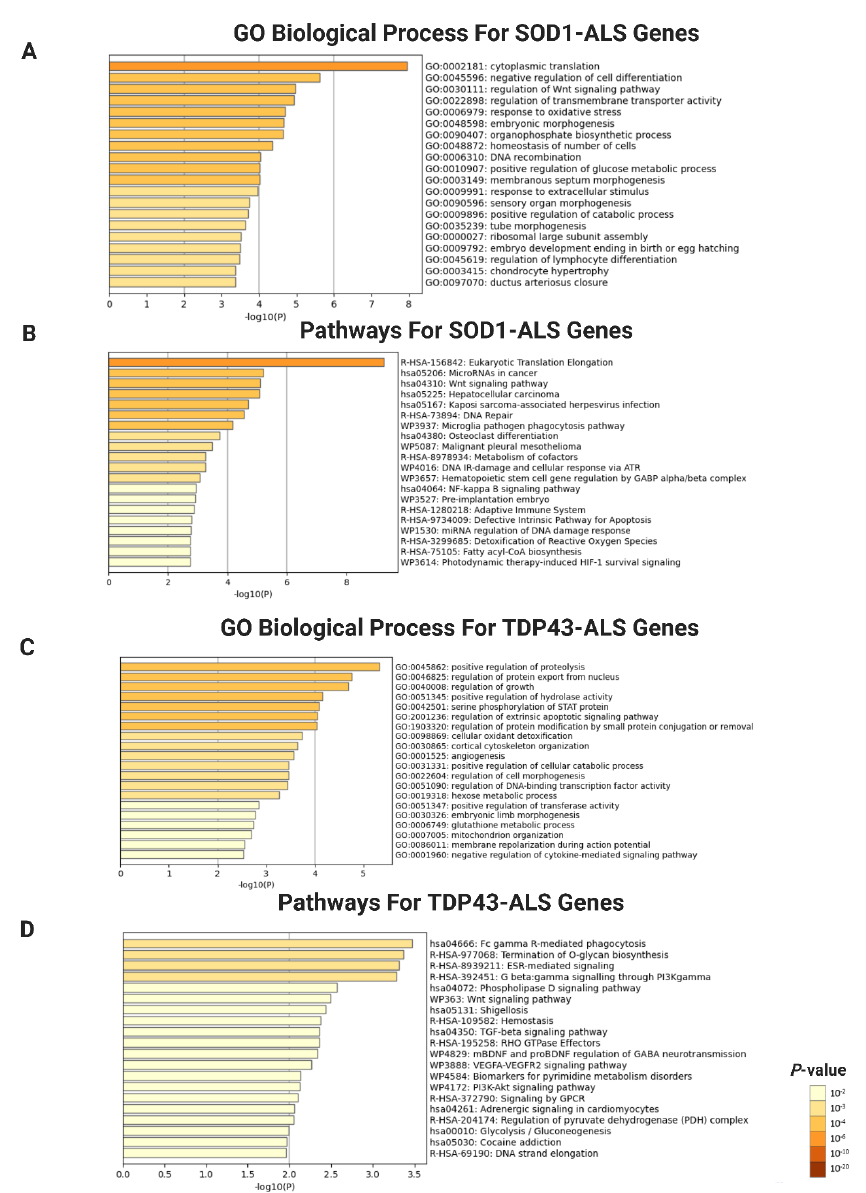
Figure 2. Functional enrichment analysis of DEGs by Metascape (https://metascape.org/gp/index.html#/main/step1, accessed on 6 July 2022) revealed distinct pathways in SOD1- and TDP43-ALS. ( A ) Metascape bar chart of enriched GO and ( B ) Pathway terms (KEGG/Reactome/WikiPathway) across the input DEGs in SOD1-ALS. ( C ) Metascape bar graph of GO terms and ( D ) KEGG pathways that are significantly enriched in DEGs specific for TDP43-ALS datasets. X-axis represents the statistical significance of the enrichment ( − log10 ( p -value)). Bar chart of GO and Pathway terms colored by p -values ≤ 0.05 were adapted from Metascape, where terms containing more genes tend to have more significant p -values. The length of the bar represents the significance of that specific gene-set or term. The brighter the color, the more significant that term